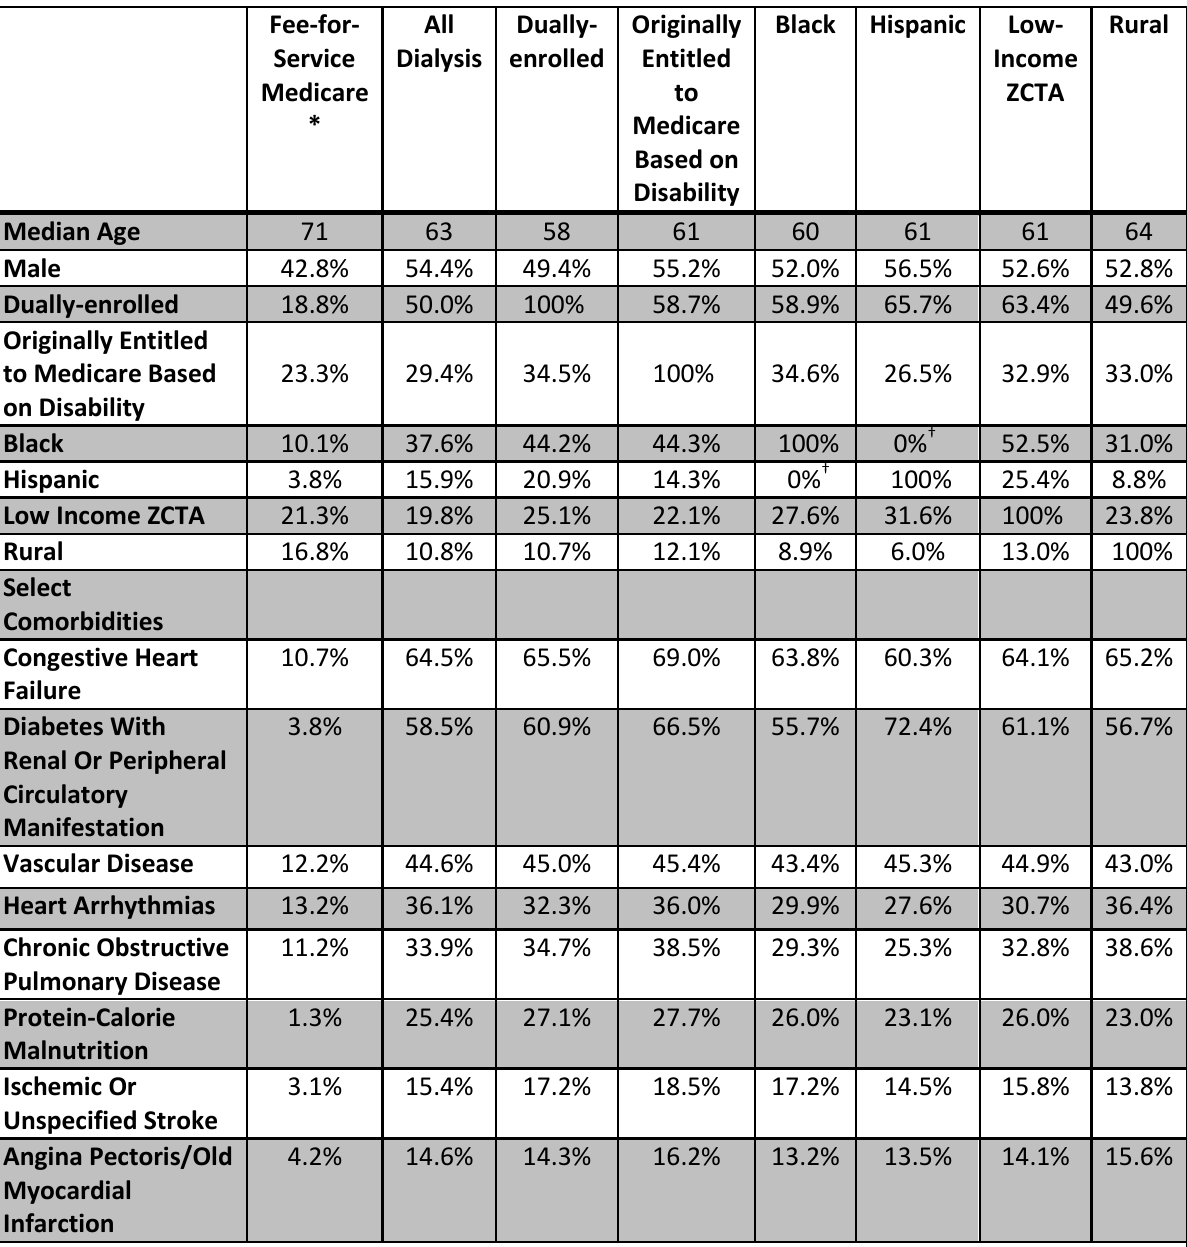
Table 11.1: Patient